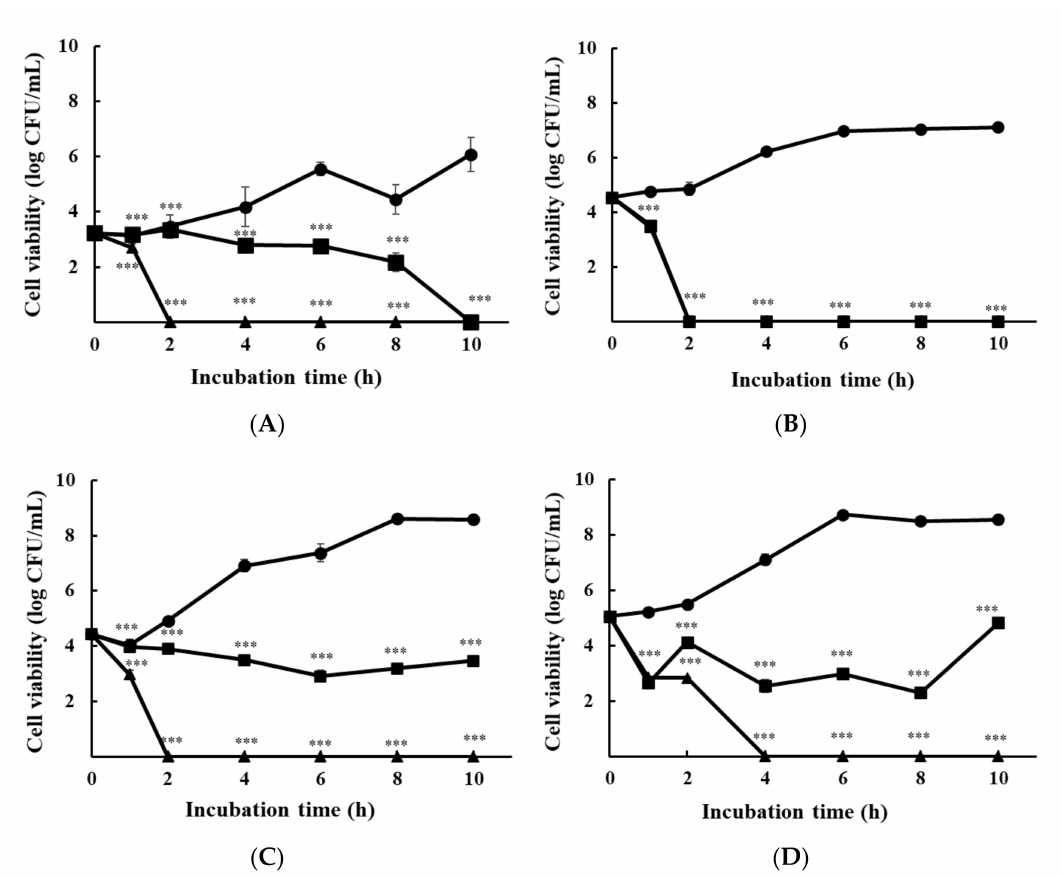
Figure 2. Time-kill analysis of ε -PL at 1/2 × MIC, 1 × MIC, and 2 × MIC against three multi-species cultured bacteria plated on a selective agar medium. Cell viability using ( A ) XLD agar for S . Enteritidis KCCM 12021; ( B ) Oxford agar for L. monocytogenes H7962 serotype 4; ( C ) EMB agar for E. coli O157:H4 FRIK 125 + E. coli ATCC 25922; and ( D ) TSA agar for S . Enteritidis KCCM 12021 + L. monocytogenes H7962 serotype 4 + E. coli O157:H4 FRIK 125 + E. coli ATCC 25922. All data are expressed as the mean ± standard error. Circle, Control; square, 1/2 × MIC; triangle, 1 × MIC. *** p < 0.001, compared to the control